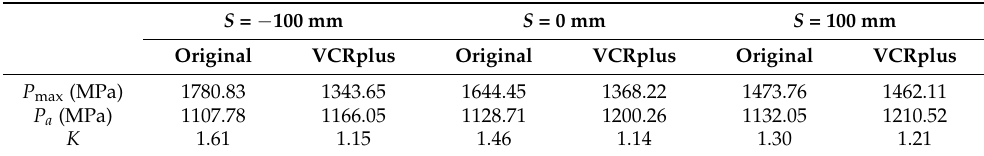
Figure 13. Comparison of the contact pressure between the rolls at different roll shifting positions, S , ( B = 1200 mm, q = 12.5 kN/mm). Table 8. The coefficient, K , at different roll shifting positions, S .